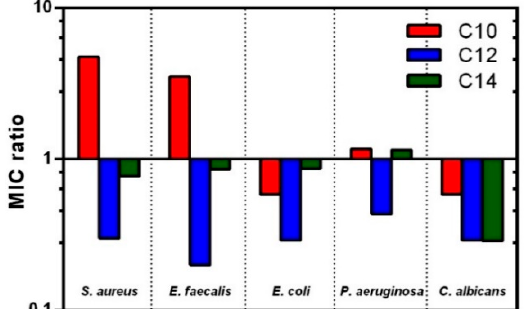
Figure 5. Comparison between MIC values from leucine-based quaternary ammonium surfactants (C10, C12 and C14) without or in the presence of the benzyl group. The MIC ratio is calculated from the ratio of MIC values for leucine surfactants without and with the benzyl group. MICs for surfactants without the benzyl group are from [14].